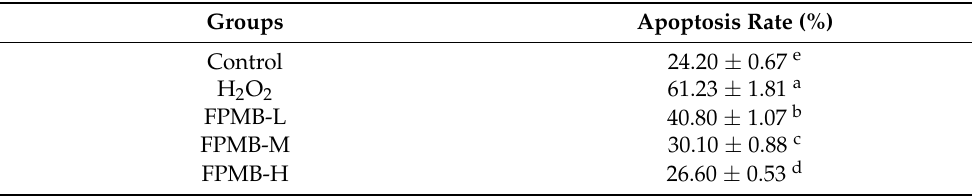
Results are mean ± standard deviation. The total number of mice was 12. Different lowercase letters in the same column within the same sample express significant differences ( p <